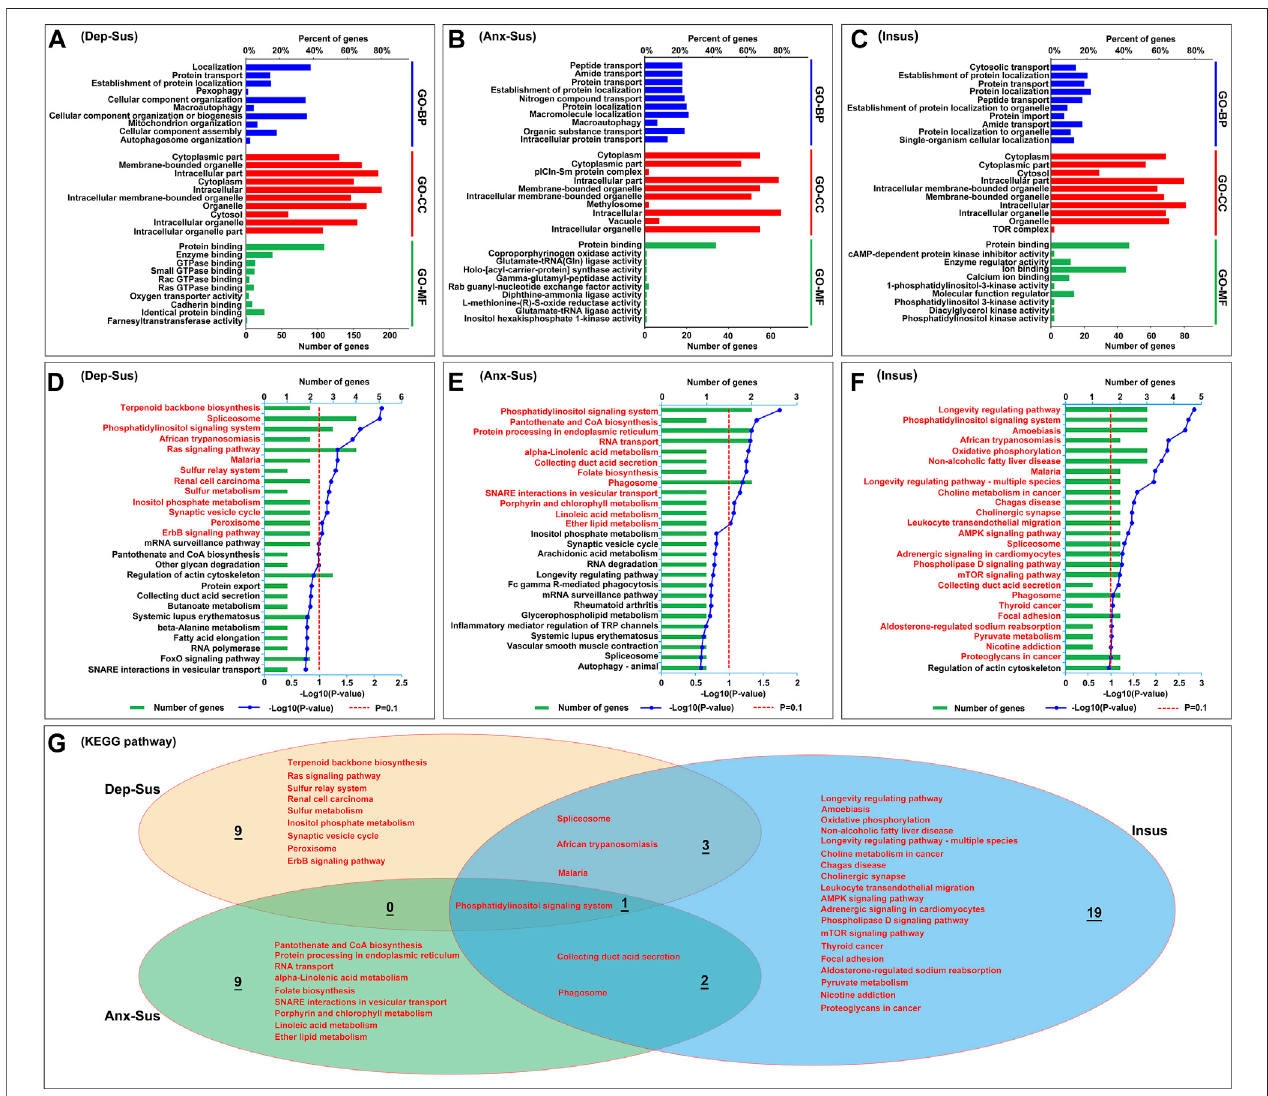
FIGURE3| AnalysisresultsoftheGOandKEGGpathwayenrichmentsforabnormallyexpressedproteins. (A – C) Thetop10mostsigni fi cantenrichedentriesinthe three categories, including biological process (GO-BP), cellular component (GO-CC), and molecular function (GO-MF) were displayed in the depression-susceptible [Dep-Sus, (A) ], anxiety-susceptible [Anx-Sus, (B) ], and insusceptible [Insus, ( C )] groups. The terms in the same category are sorted using the p value. (D – F) KEGG pathway with signi fi cant protein enrichment. The pathways that are signi fi cantly enriched in the Dep-Sus (D) , Anx-Sus (E) , and Insus (F) groups were shown using titles in red. (G) Venn diagram showing the common and unique KEGG pathway terms in the three groups.